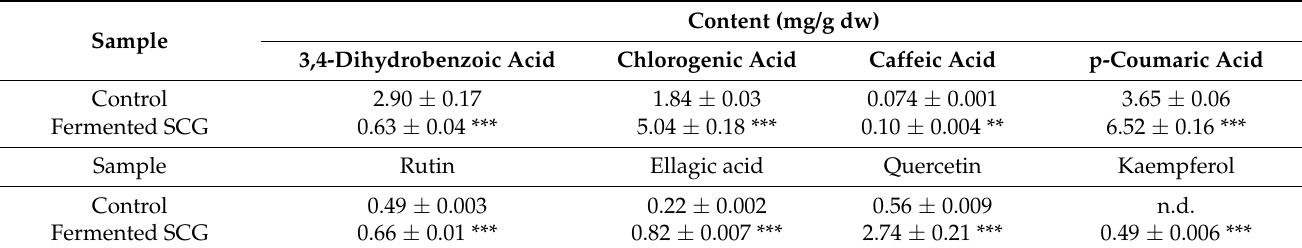
Table 2. Polyphenol compound contents in fermented SCG after 8 days of submerged culture.